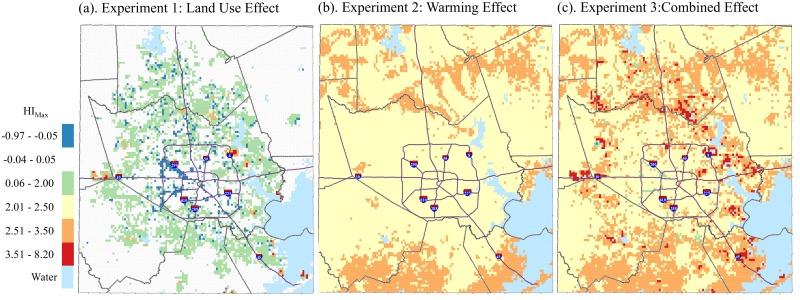
Simulated May-September median Tmin differences between (a) Future Land Use, Δ 0°C and Present Land Use, Δ 0°C; (b) Present Land Use, Δ 1°C and Present Land Use, Δ 0°C.